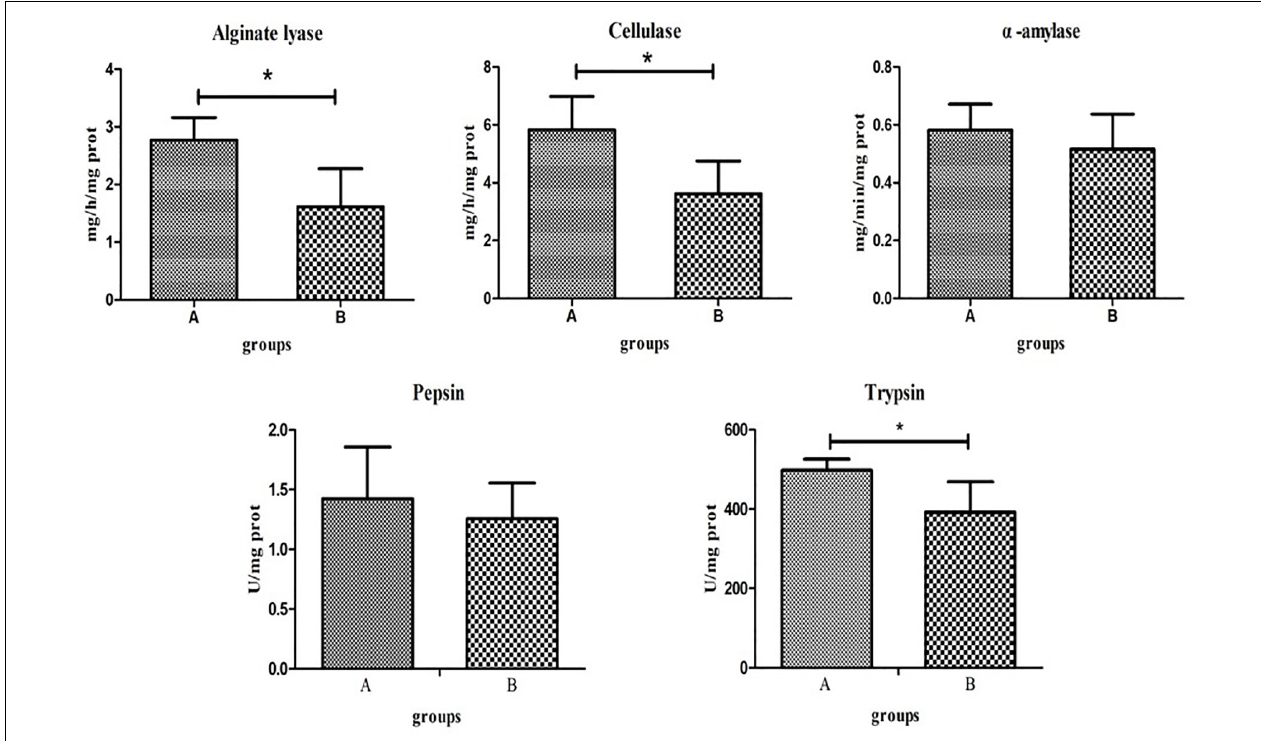
FIGURE 6 | Key digestive enzyme activity and protease activity in the intestines of the high- and low-residual feed intake (RFI) groups. “*” represents a significant difference ( P <